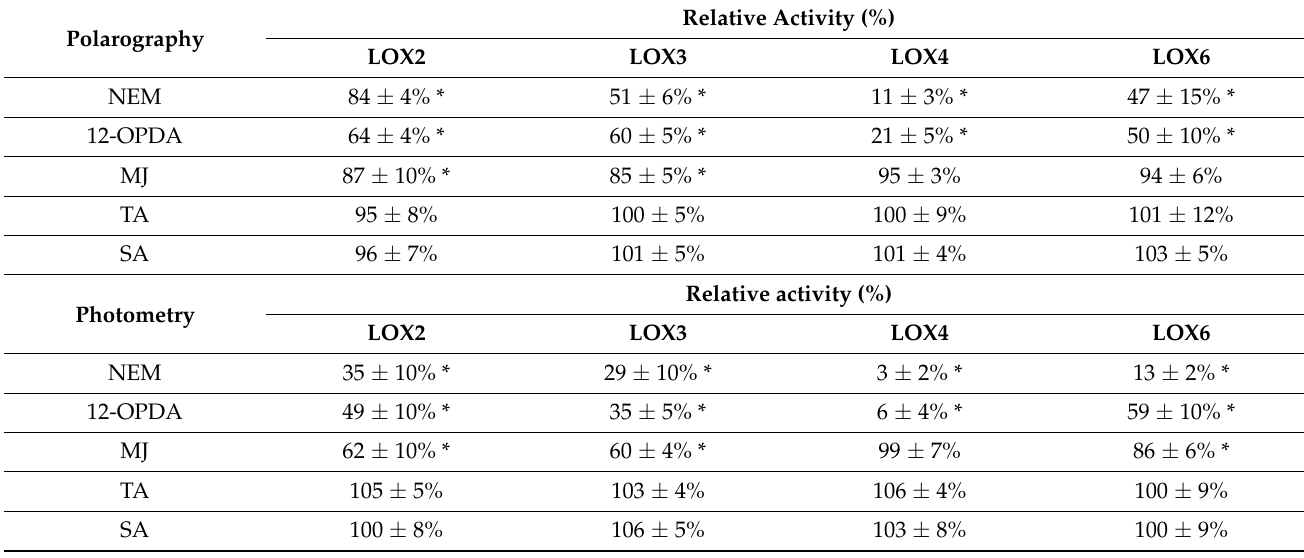
Upper table, polarographic recordings. LOX6: 90 µ L (1.0 µ g/ µ L) was incubated with 10 µ L 2.8 mM chemicals or solvent, LOX2, LOX3: LOX4: 45 µ L (0.5 µ g/ µ L) were incubated with 5 µ L 2.8 mM chemicals or solvent and injected into 1.8 mL LeA (30 µ M in 50 mM